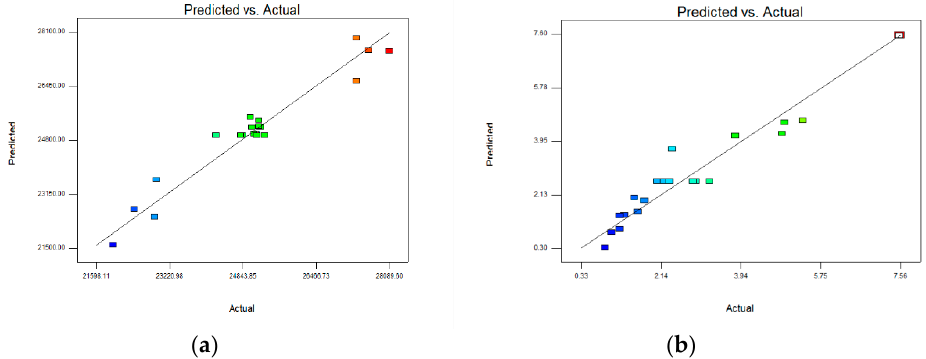
Figure 2. Prediction versus actual regression model ( a ) heating value ( b ) compressive strength.